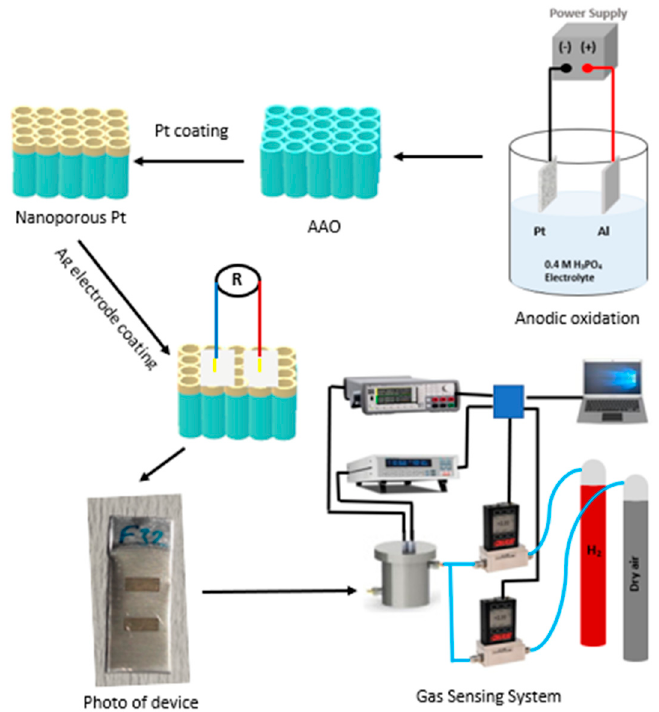
Figure 6. A schematic description of the experimental process and setup. The formation of the AAO template by anodization method, Pt coating on AAO with a thin film coating system, deposited Ag electrodes on Pt NP and a photo of the sensor device and the gas measurement system (adapted from [35]).